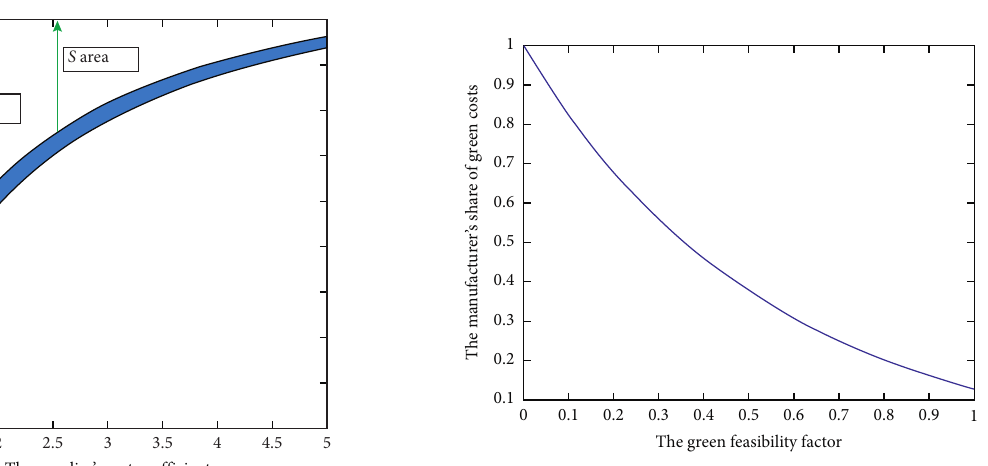
Figure 8: The relationship between the manufacturer’s share of green cost and the green feasibility factor.